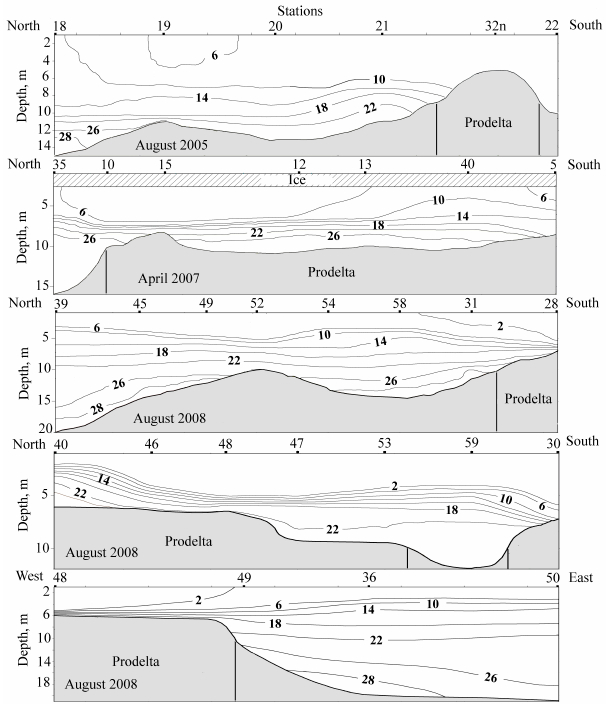
Fig. 3. Vertical sections of salinity (‰) distribution for years 2005, 2007 and